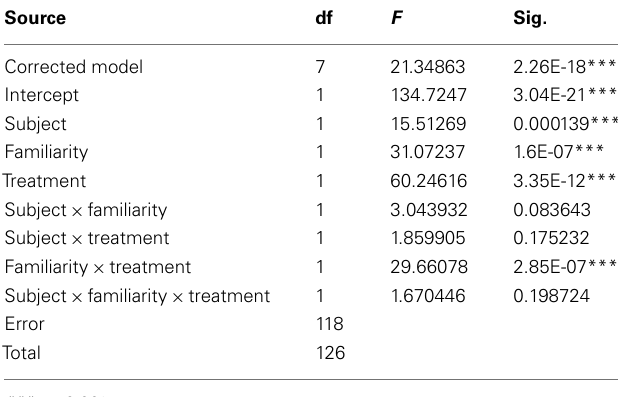
Table 2 |Three-factor univariateANOVA of correct categorization performance dependent variable: difference in performance (drug–saline) treatment factor: two levels: scopolamine or butyl-scopolamine.